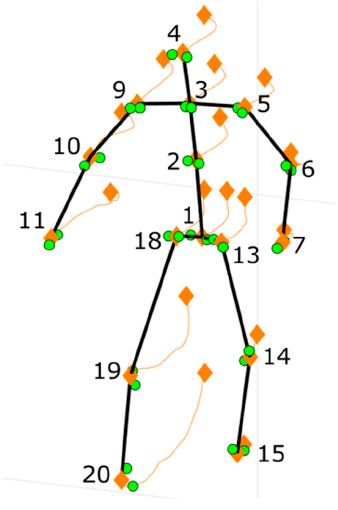
Figure 3. Output of the fused skeleton and the trajectories of the nodes in time. Green dots represent the nodes measured from different Kinects. Orange diamonds indicate the nodes of the fused skeleton and orange lines are their trajectories.